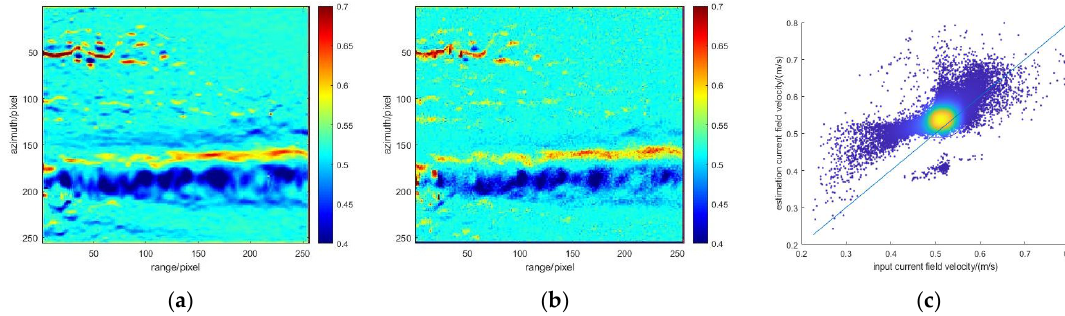
Figure 12. The velocity calculation results based on the direct method: ( a ) the input velocity, ( b ) the current velocity calculated directly from the interferometric phase, and ( c ) the scatter density map of the input and calculated current velocities.